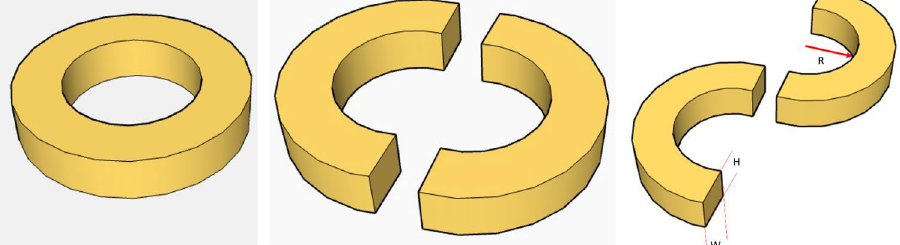
Fig. 3 Toroid format used to calculate the surface area of the filling